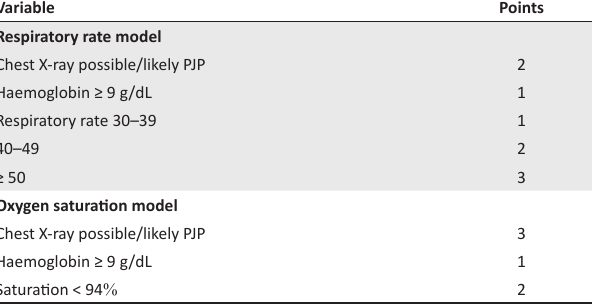
TABLE 4: Clinical prediction rules derived from the respiratory rate and oxygen saturation multivariable logistic regression models for the diagnosis of Pneumocystis jirovecii pneumonia among 500 seriously ill HIV-infected participants presenting with a cough of any duration and one or more World Health Organization danger signs.